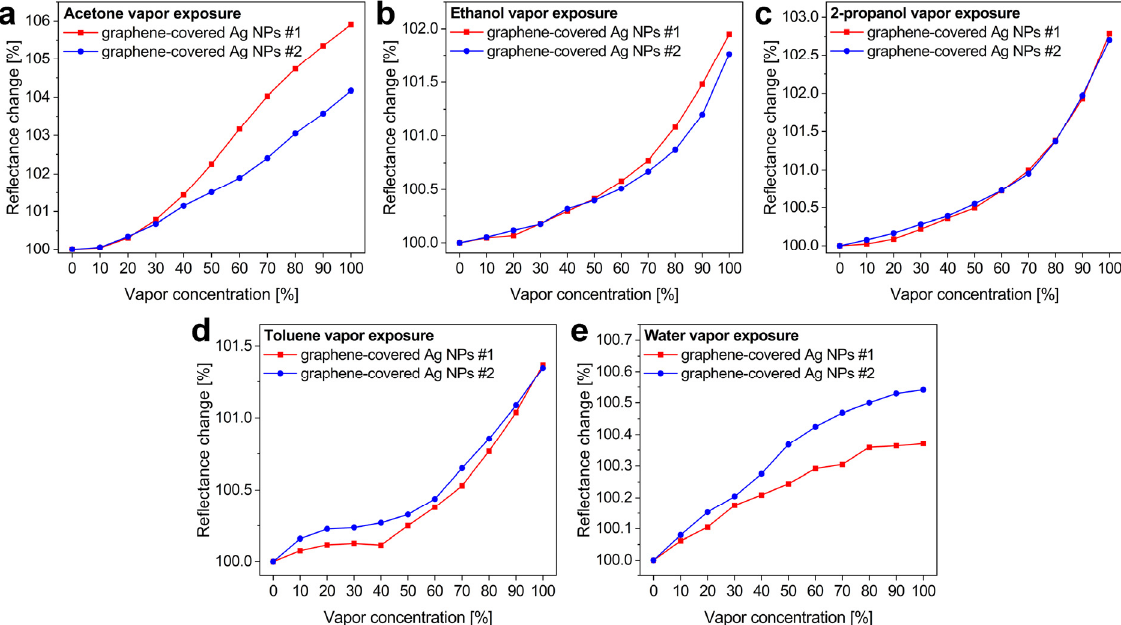
Figure 7. Maximal peak intensities in the reflectance change spectra as a function of vapor concentration. For each applied vapor, the optical responses of samples #1 and #2 are compared. ( a ) Acetone, ( b ) ethanol, ( c ) 2-propanol, ( d ) toluene, and ( e ) water vapors were applied.